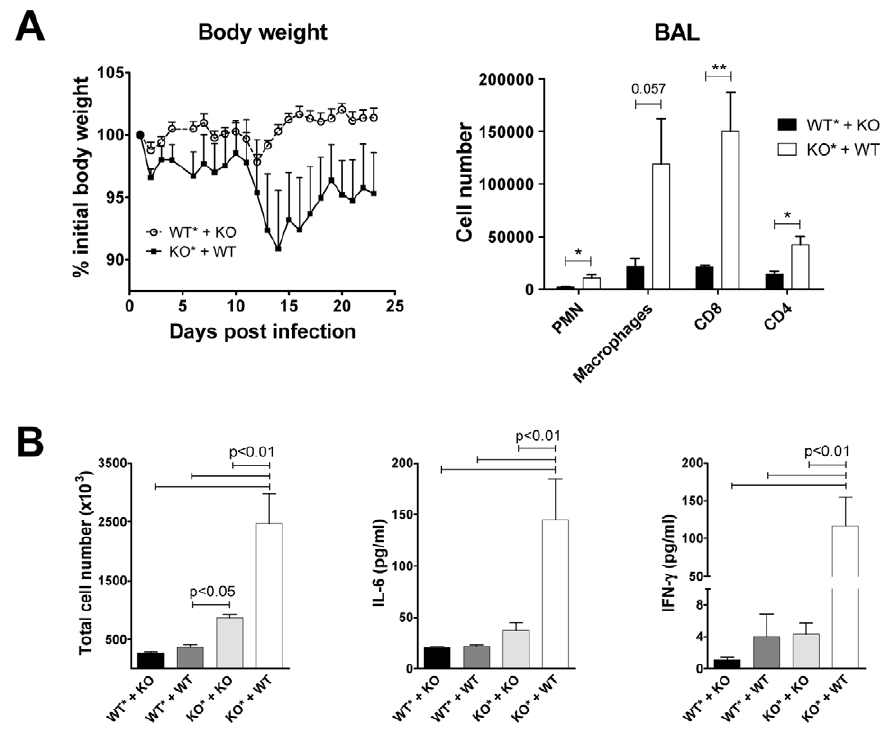
Figure 8. Transfer of bone marrow from wild-type mice does not protect ChemR23-deficient mice from PVM infection. ( A ) Irradiated (*) wild-type mice reconstituted with ChemR23 2 / 2 bone marrow (WT* + KO), as well as irradiated KO mice reconstituted with bone marrow from WT mice (KO* + WT), were infected by PVM (1000 PFUs) and monitored for weight loss (left panel). 23 days post-infection, mice were sacrificed and inflammatory cells were counted in BAL fluids (right panel). ( B ) BAL fluids were also harvested at day 14 post-infection in a similar experiment including two additional groups, namely WT and KO mice reconstituted respectively with WT and KO bone marrow (WT* + WT, KO* + KO, respectively). Total cell numbers (left panel) as well as cytokine levels (IL-6 and IFN- c , middle and right panels) were determined in these samples. Data are the mean 6 SEM for groups of at least five animals. *, p , 0.05; **, p , 0.01.